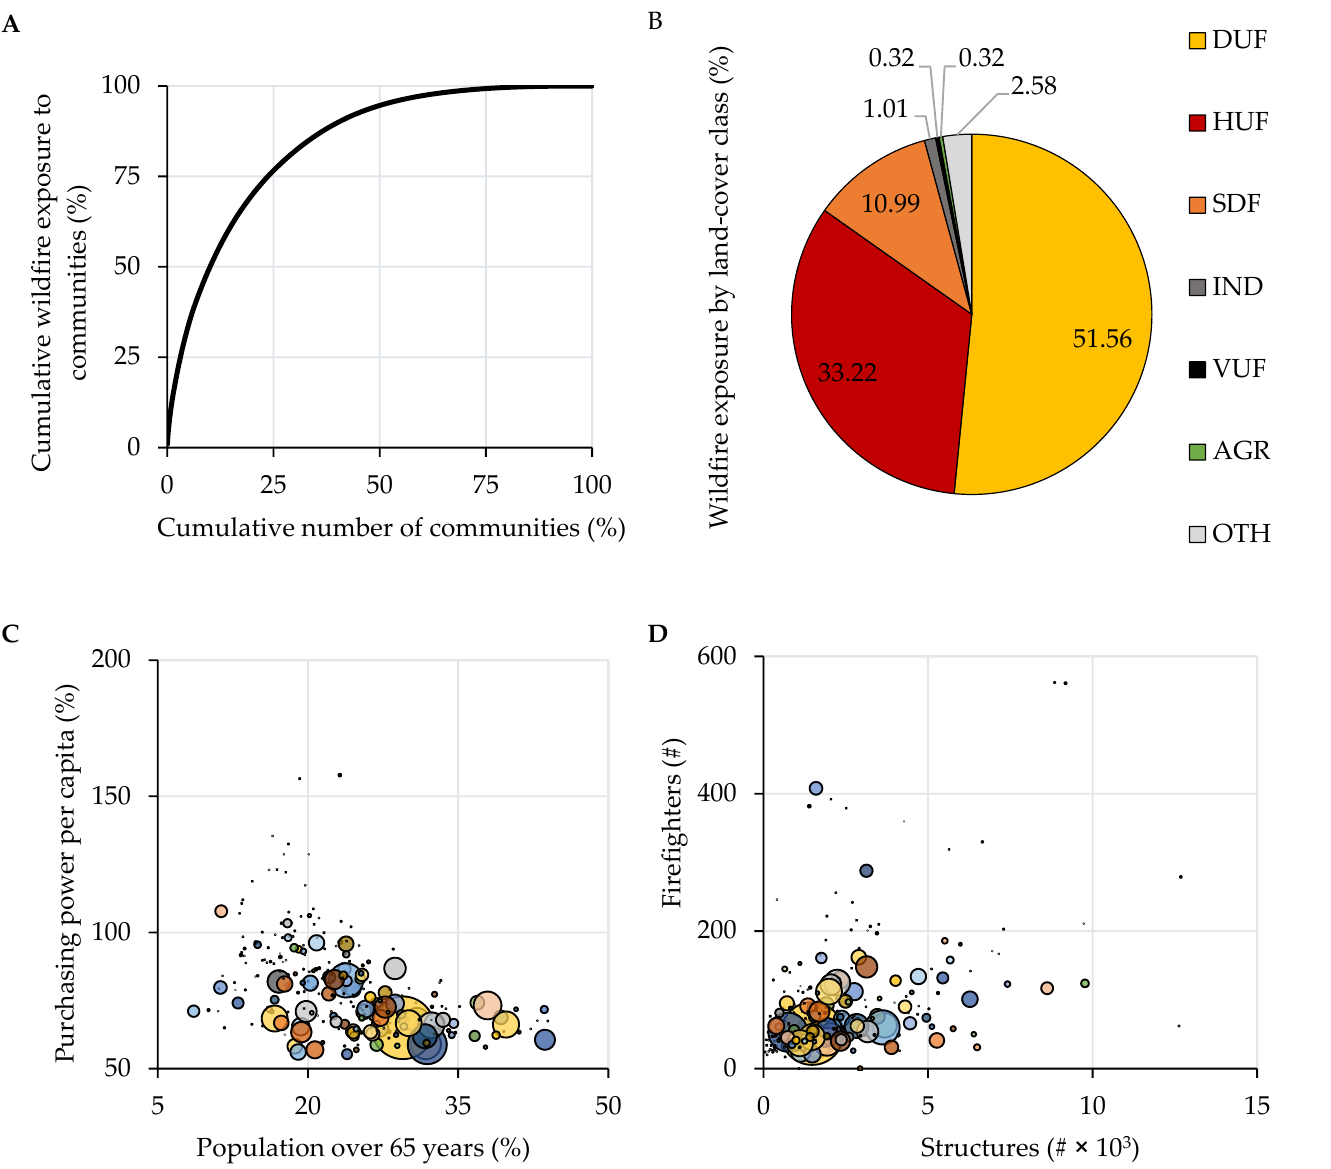
Figure 6. Cumulative wildfire exposure ( A ), exposure by urban fabric buildup class ( B ), social vulnerability ( C ), and response capacity ( D ) in communities. The bubble size ( C , D ) represents the community-level exposure ratios (Figure 4B). The maximum bubble size is a 0.15 exposure ratio. Abbreviations: discontinuous urban fabric (DUF), predominantly horizontal continuous urban fabric (HUF), sparse discontinuous urban fabric (SDF), industrial (IND), mostly vertical urban fabric (VUF), agricultural facilities (AGR), and other (OTH).